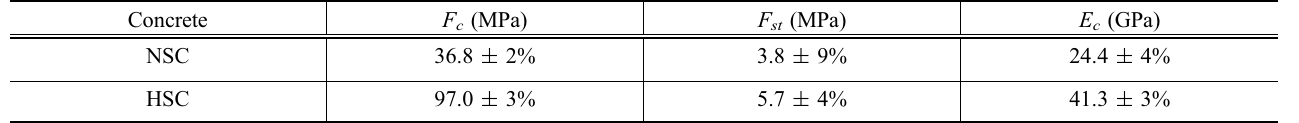
Table 2 Mechanical properties of NSC and HSC concrete